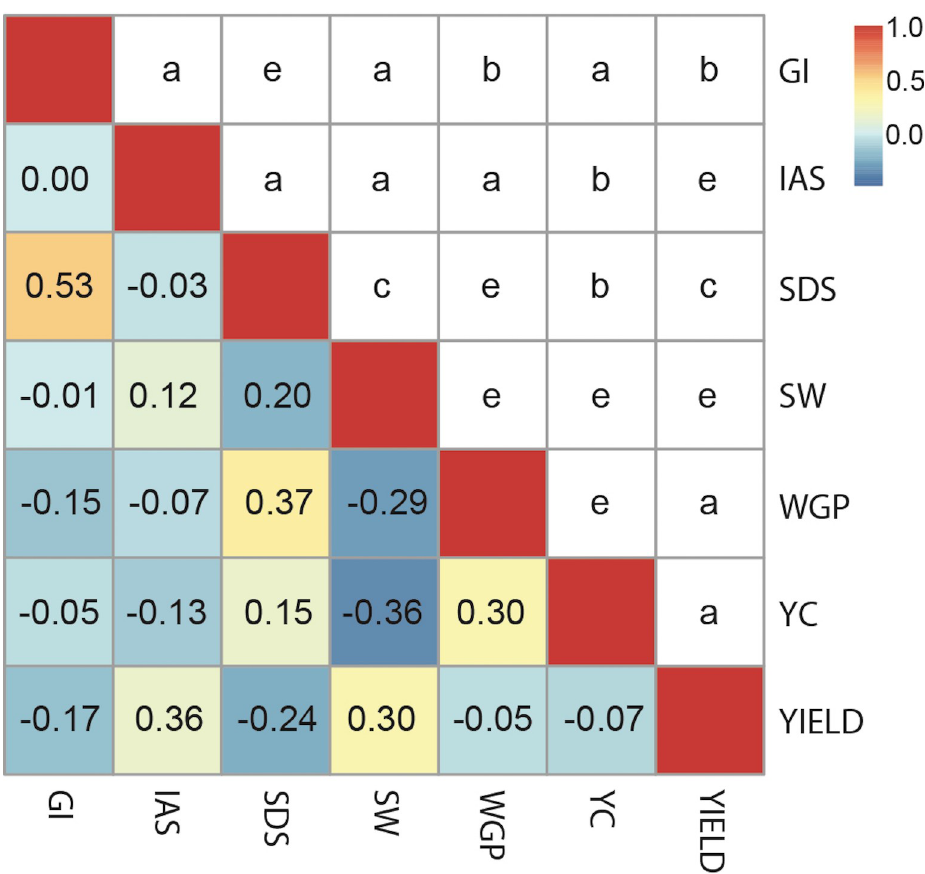
Fig 1. Phenotypic correlations found among assessed traits. GI: gluten index; IAS: initial agronomic score; SDS: sedimentation index (SDS); SW: specific weight; WGP: whole grain protein; YC: yellow colour; and YIELD: grain yield. Above, the range for p-values was indicated using a scale from “a” to “e” (a: represents p-values larger than 0.1; b: represents values between 0.1 and 0.01; c: represents values between 0.01 and 0.001; d: indicates values between 0.001 and 0.0001; e: for values between 0.0001 and 0.00001); below, correlations are shown using a colour scale (highest correlations in red, lowest correlations in blue).